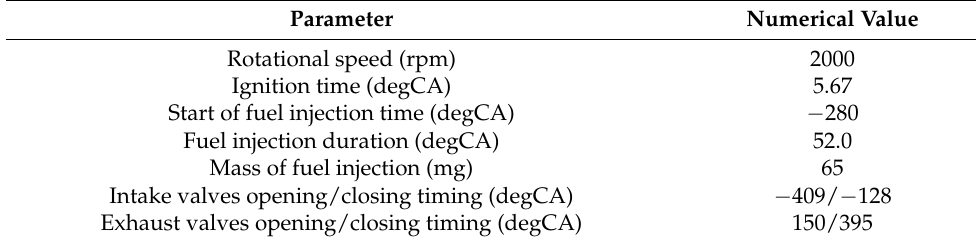
Table 2. Operating conditions of the GDI engine.